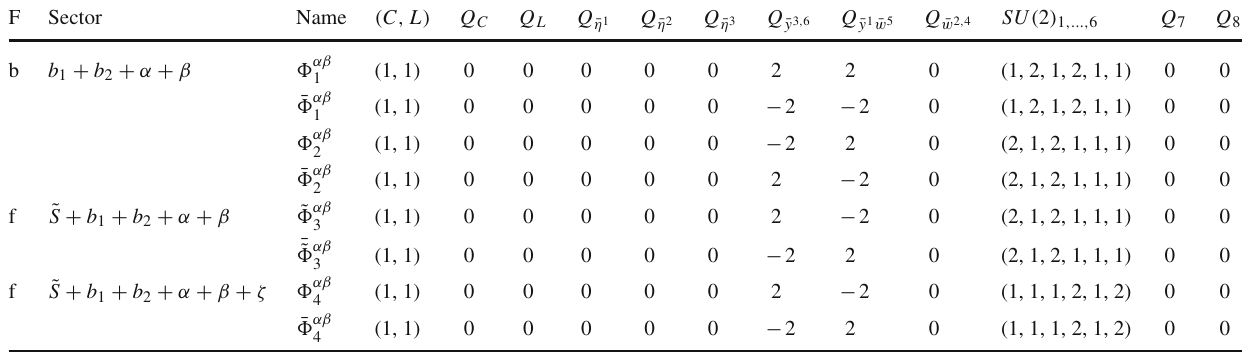
Table 4 The hidden sectors. All charges are multipled by 4 and the combination ζ = 1 + b 1 + b 2 + b 3 has been used F